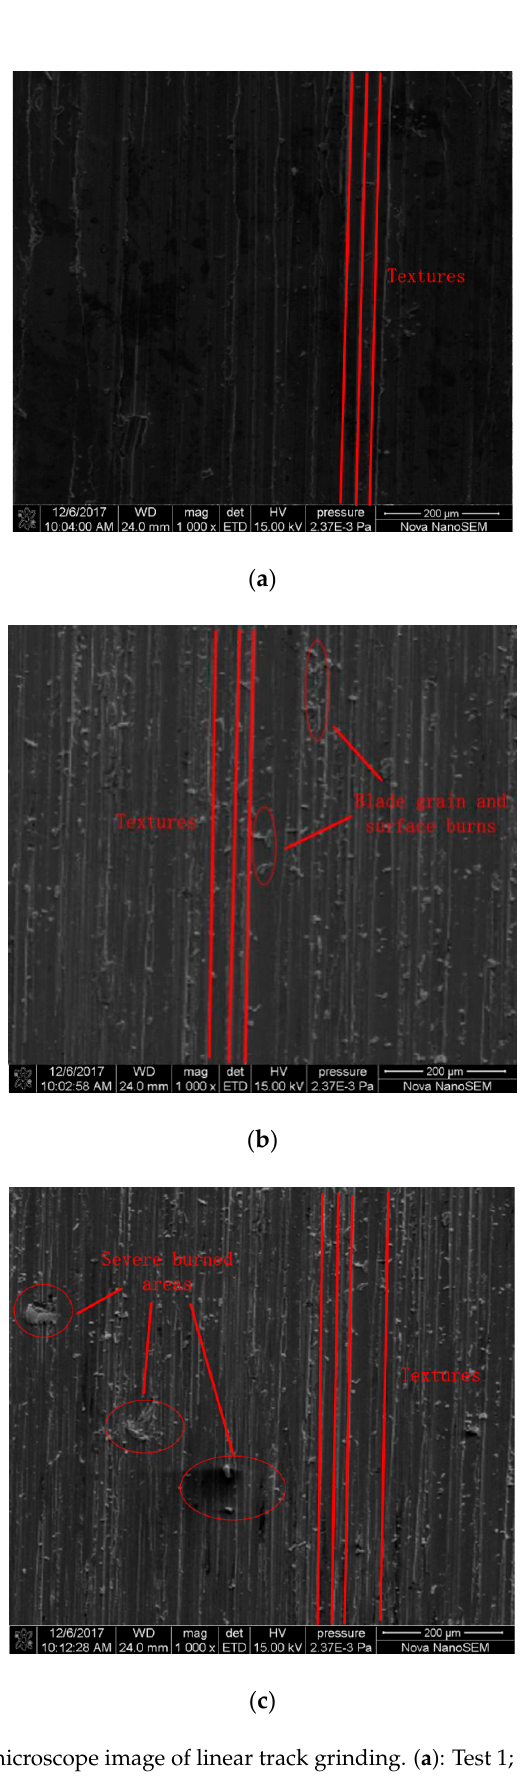
Figure 6. Electron microscope image of linear track grinding. ( a ): Test 1; ( b ): Test 6; ( c ): Test